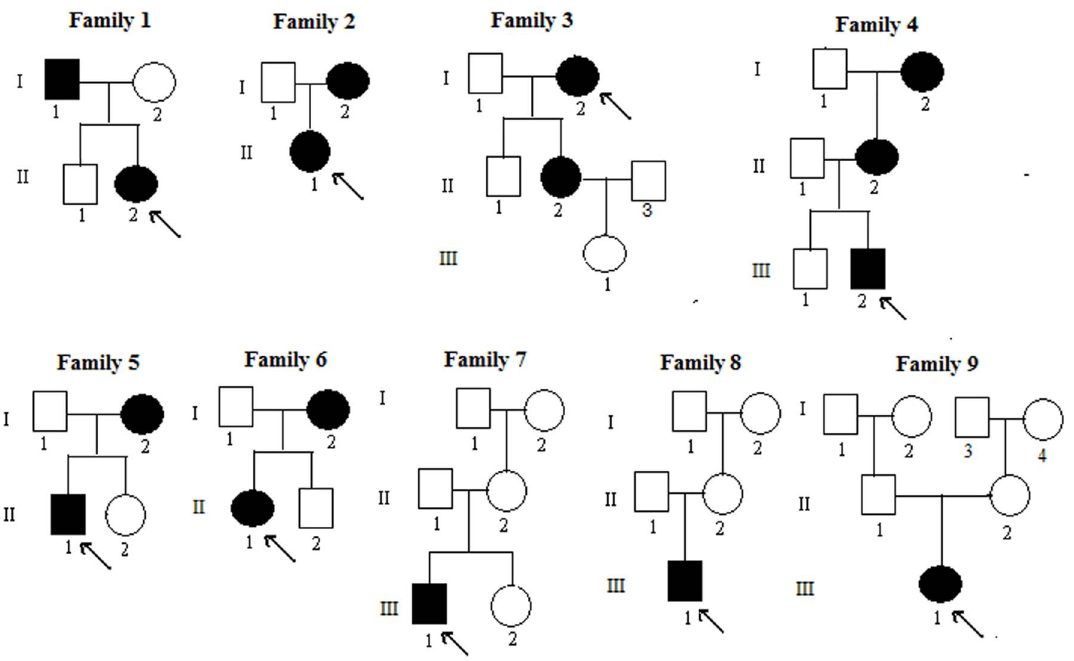
Figure 1. Pedigree of the familial patients with XLH. Black symbols represent the affected individuals, and open symbols represent the unaffected individuals. Circles and squares represent the females and males, respectively. The arrows identify the probands in the families.